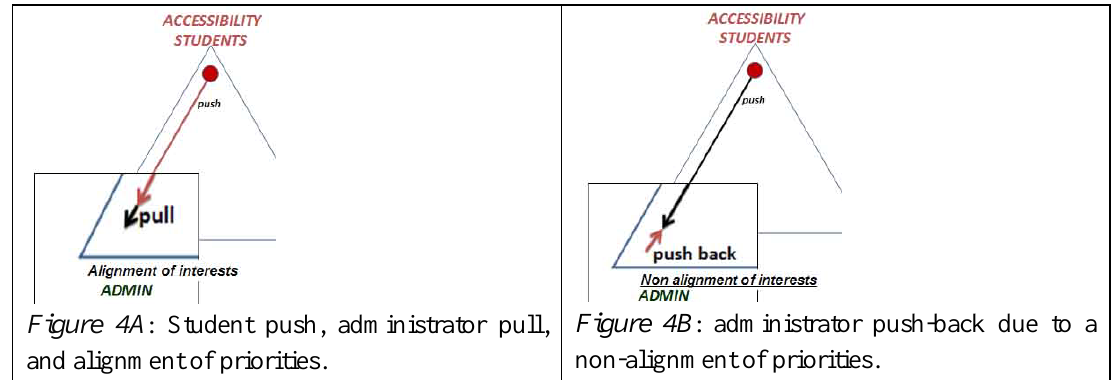
Figure 4A : Student push, administrator pull, and alignment of priorities.